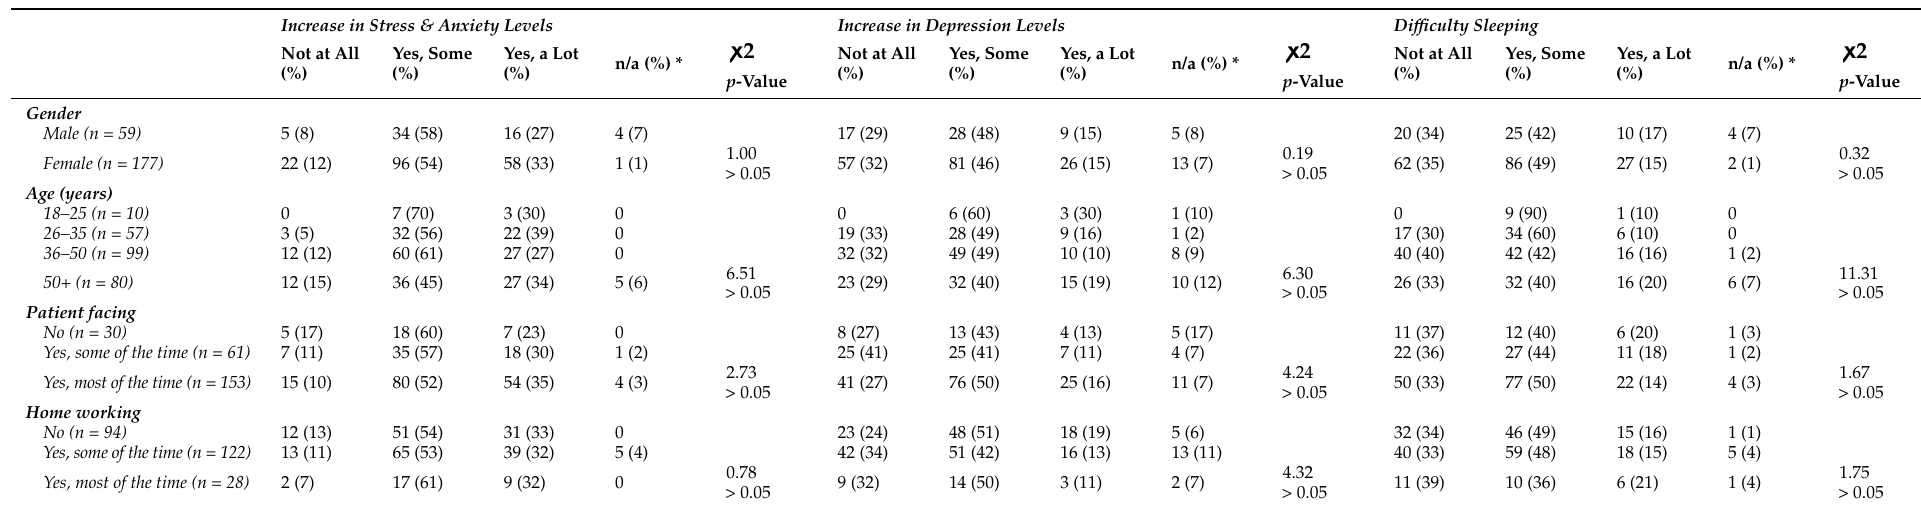
Table 1. The effect of Covid-19 on stress & anxiety, depression, and sleep in forensic staff by sample characteristics. Increase in Stress & Anxiety Levels Increase in Depression Levels Difficulty